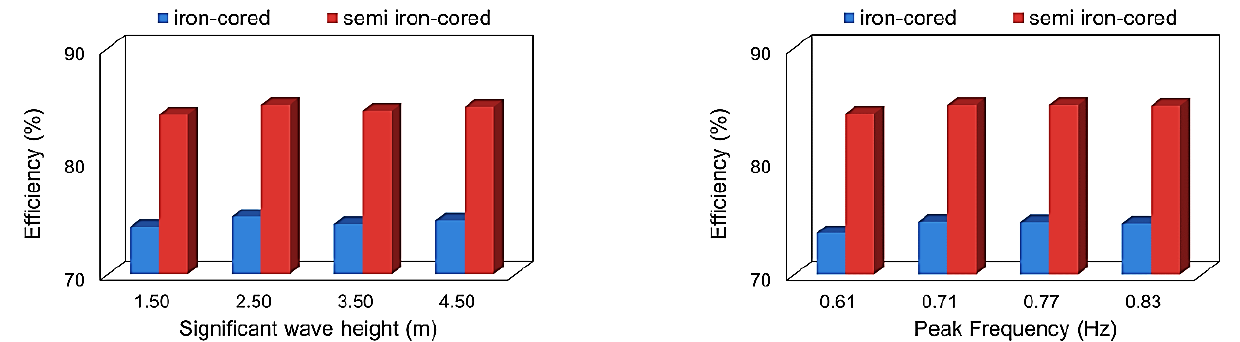
Figure 26. Electrical efficiency of the LPMG designs under random wave configurations.